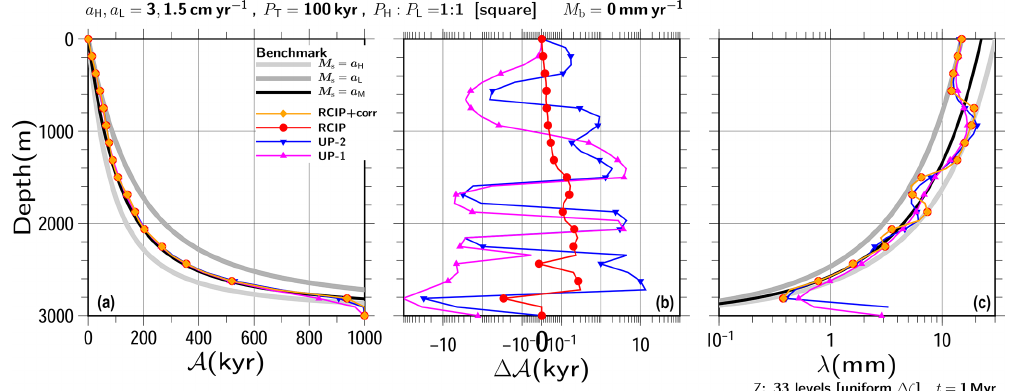
Figure 17. Same as Fig. 7, except for the experiment with the lower vertical resolution of 33 uniform grid spacing. Symbols are plotted for every two vertical